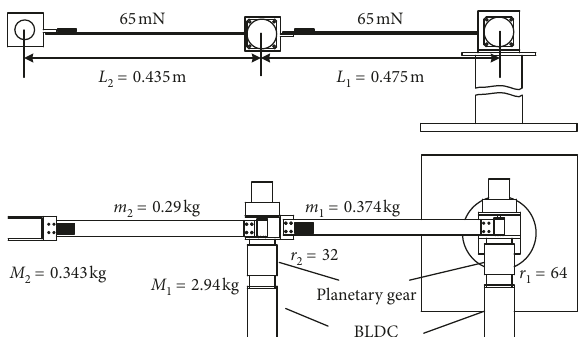
Figure 7: Schematic diagram of the assembly structure of 2-DOF flexible manipulators.